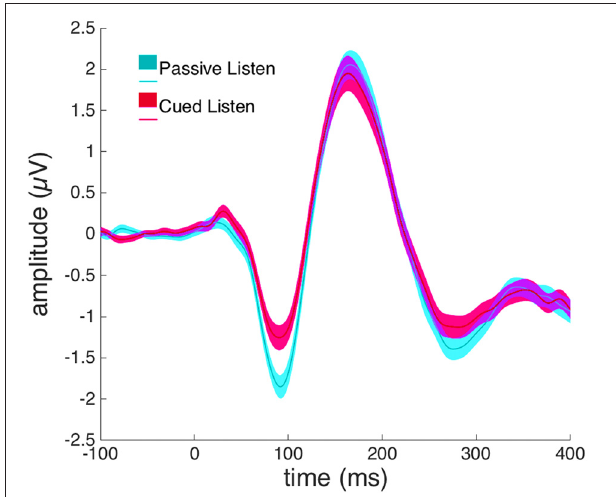
FIGURE 3 | Event-related potentials (ERPs) from electrode Cz in response to willed vocalization in the Cued Listen (magenta) and Passive Listen (cyan) conditions.